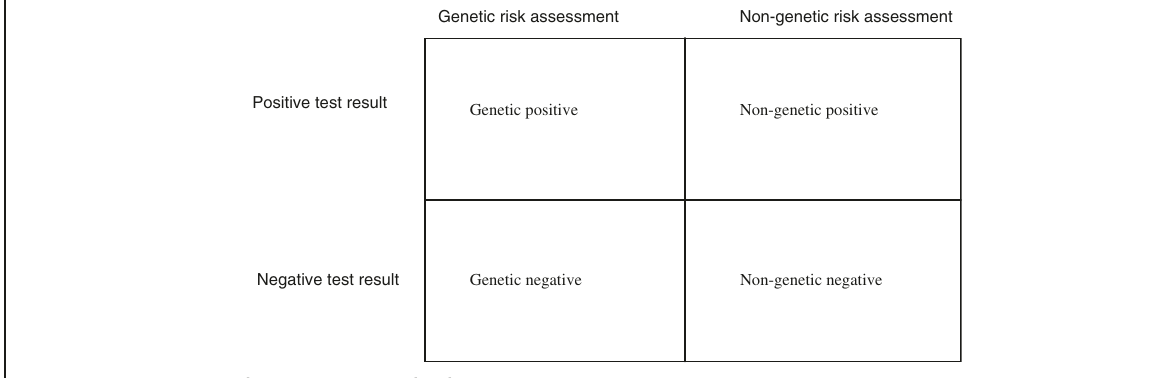
Figure 1 Participant sampling categorisation by